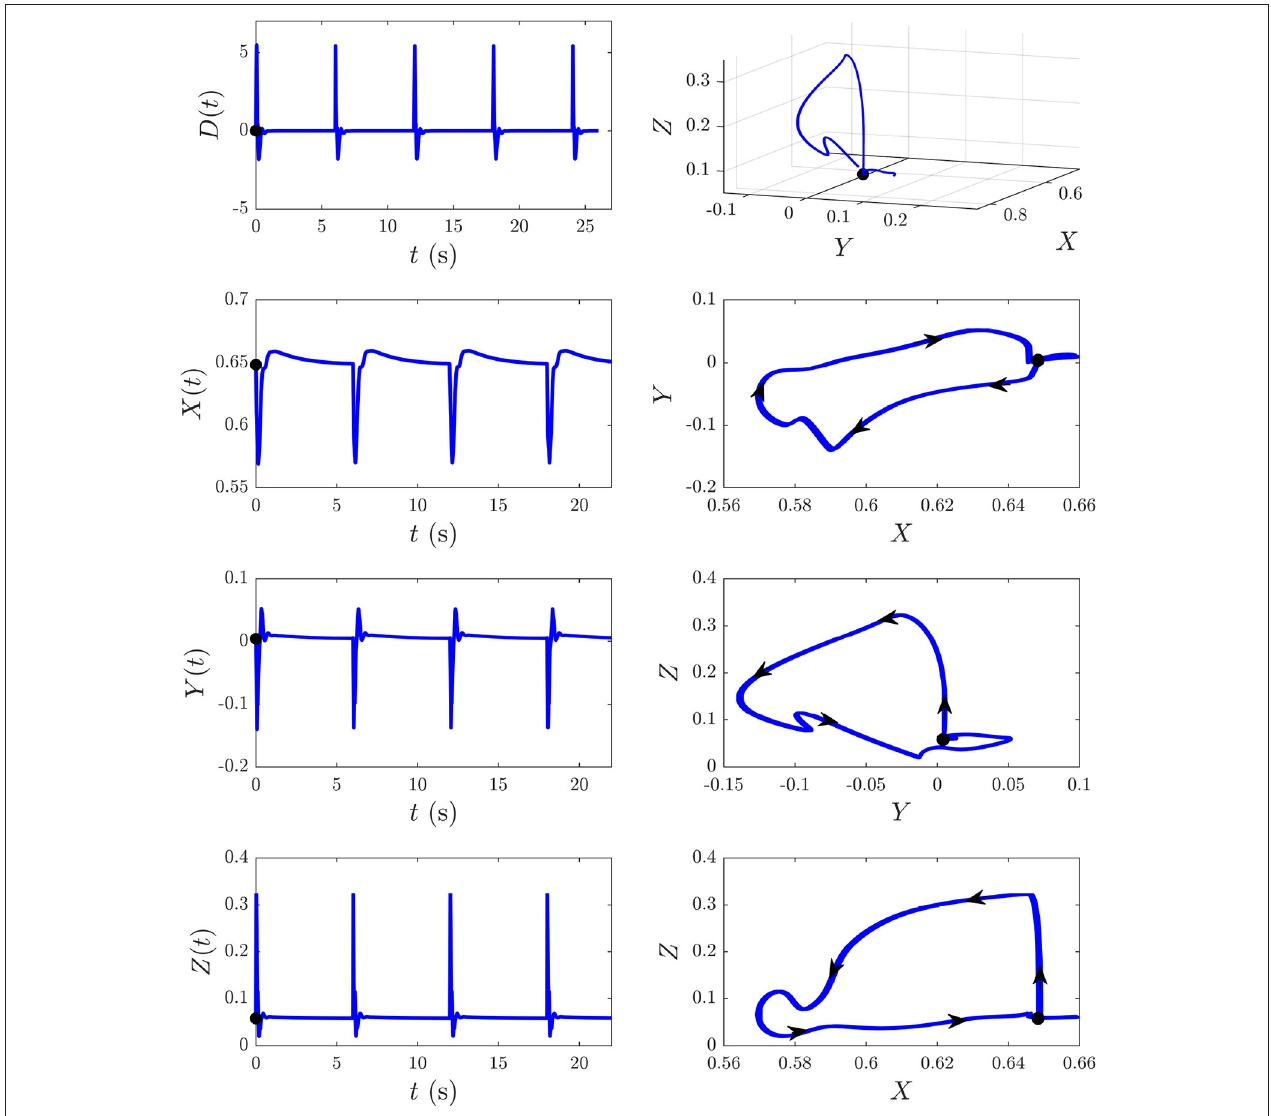
FIGURE 8 | The D responses from Figure 6B and their associated trajectories in XYZ space ( X , Y , and Z are intracortical, corticothalamic, and intrathalamic loop strengths, respectively). The black dot indicates the start point t 0. First column shows the sequence of evoked responses at 6 s ISI and corresponding X ( t ), Y ( t ), = and Z ( t ). Second column shows this trajectory in XYZ space and in the XY , YZ , and XZ planes, where the arrows indicate the direction of